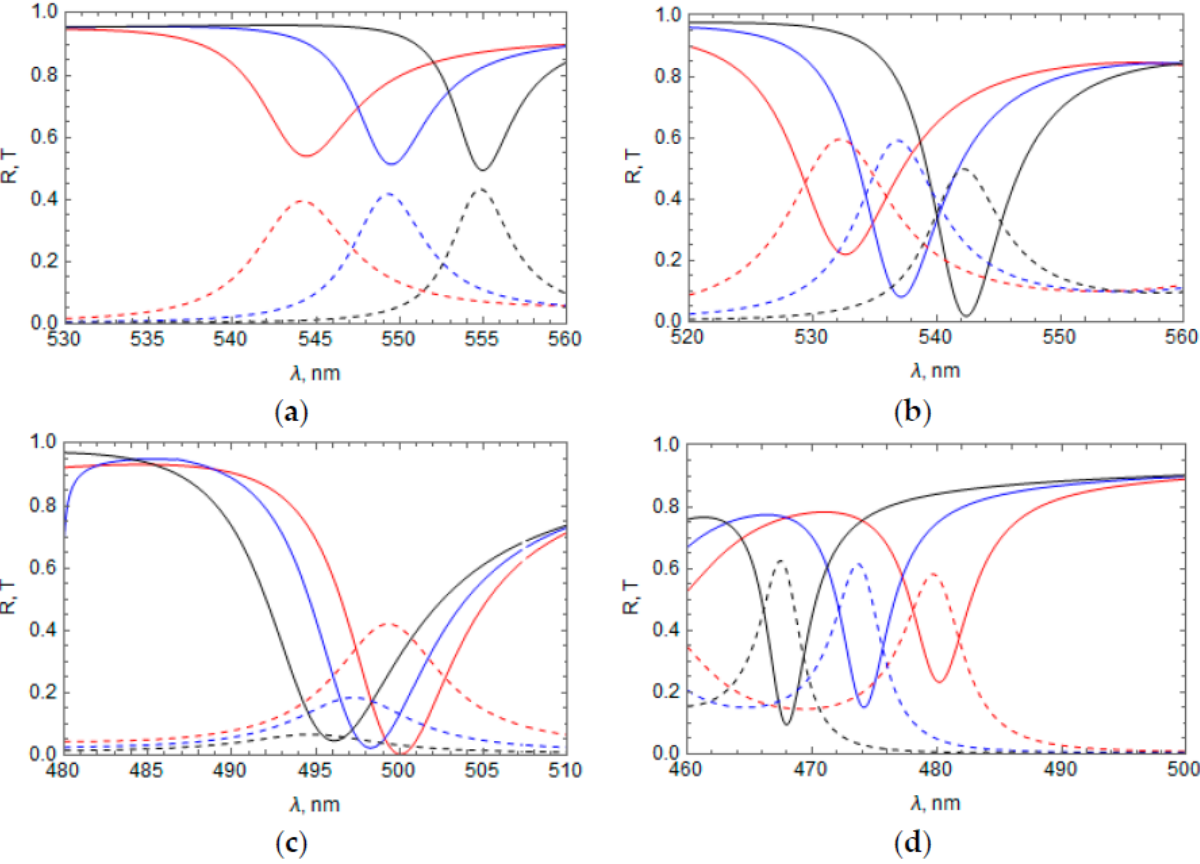
Figure 6. Reflectance and transmittance of the system at different values n p = 0.15 (red), 0.2 (blue), and 0.25 (black); ( a ) TPP band 1; ( b ) TPP band 2; ( c ) TPP band 3; ( d ) TPP band 4. Thickness of the Ag layer = 35 nm, a = 137.1 nm, n =